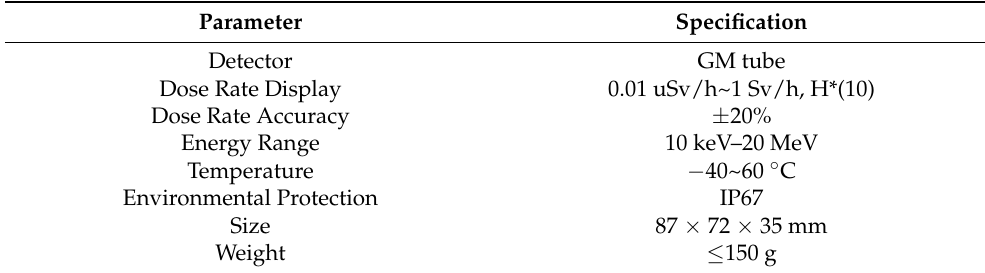
Figure 2. The photo of the nuclear radiometer used in this study. Table 1. Parameter specifications for the radiometer used in this